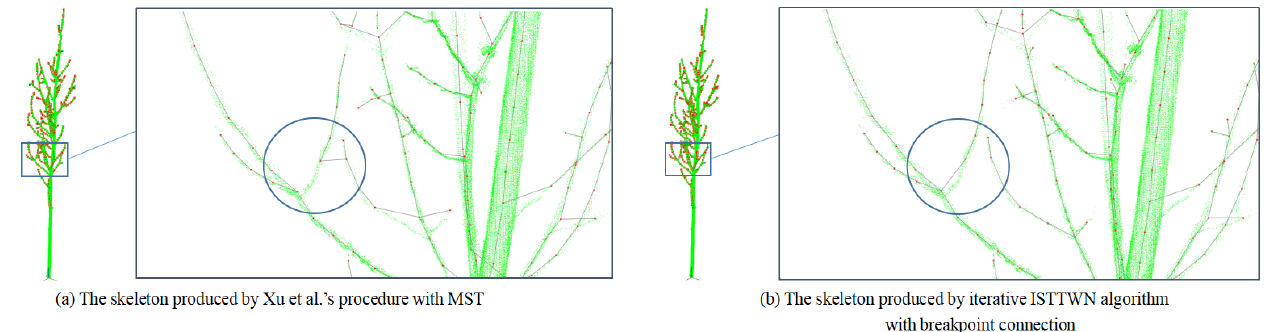
Figure 11. Topological errors in the skeleton produced by Xu et al.’s procedure with MST. Table 6. Statistics that evaluate the skeleton produced by Xu et al.’s procedure. Case Proportion of the whole skeleton lines Table 7. Statistics that evaluate the skeleton produced by the proposed algorithm. Case Proportion of the whole skeleton